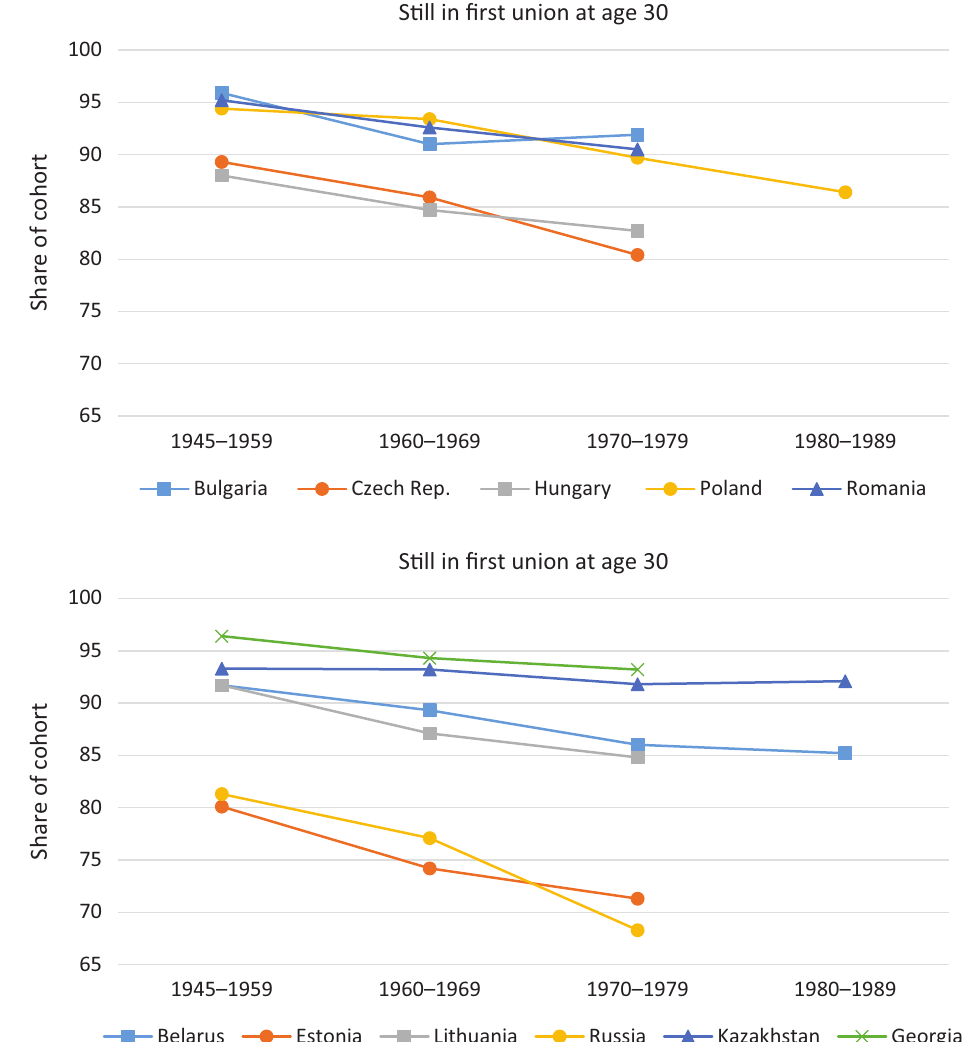
Figure 3. Share of women that are still in their first co‐residential union at the age of 30 by country and birth